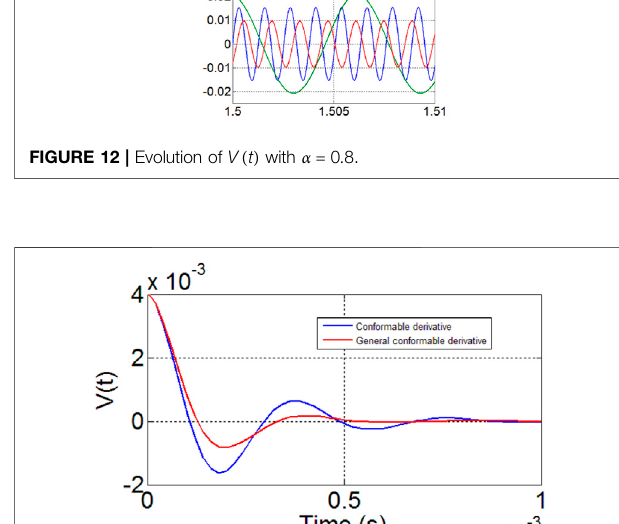
FIGURE 14 | Evolution of V ( t ) with. α (cid:2) 0 . 9.